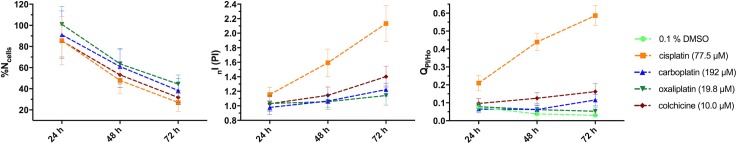
Comparison of %Ncells, nI(PI) and QPI/Ho obtained over time for PANC-1 cells exposed to Pt drugs and colchicine.Values are acquired as mean ± SD from at least 2 wells/condition and 9 field of view/well. For fluorescent microscopy pictures of PANC-1 and A549 cells after 72 h of exposure to the Pt drugs, see S14 and S15 Figs.